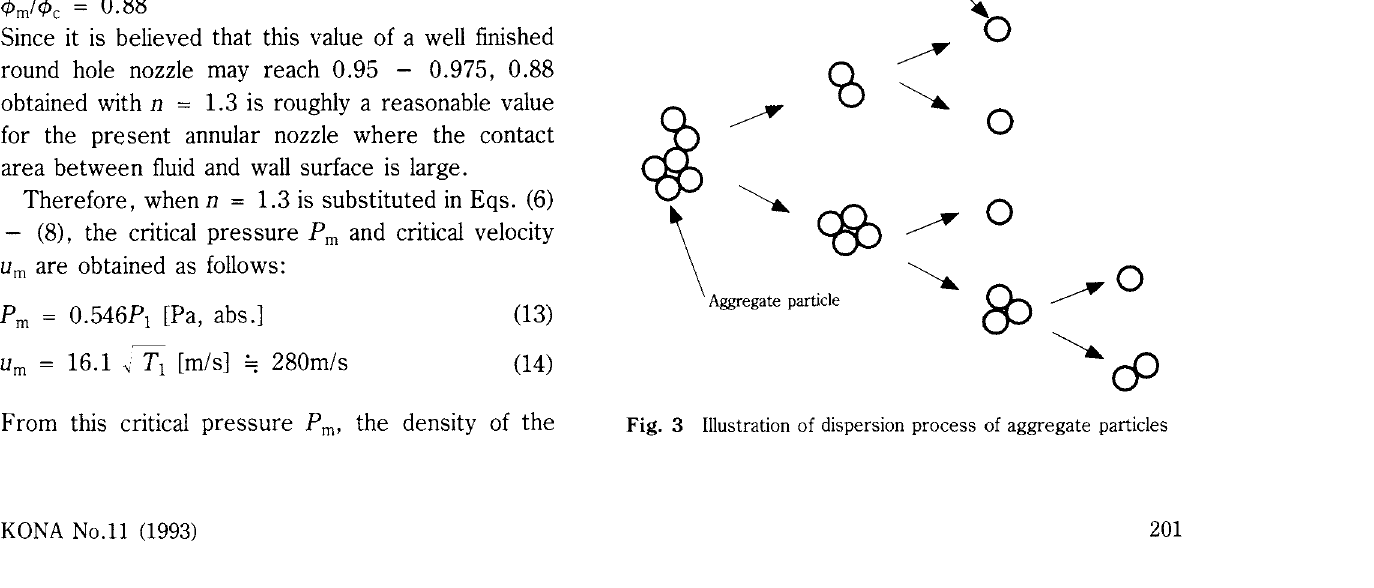
Fig. 3 Illustration of dispersion process of aggregate